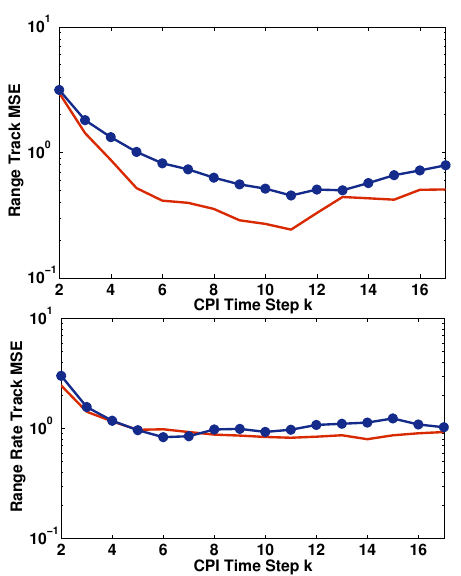
Figure 8. MSE for range ( top ) and range–rate ( bottom ) estimation when the radar OLFM waveform FM rate is − b 20 ( red ) and − b 1 ( blue ) for three users at − 18 dB SINR at the radar